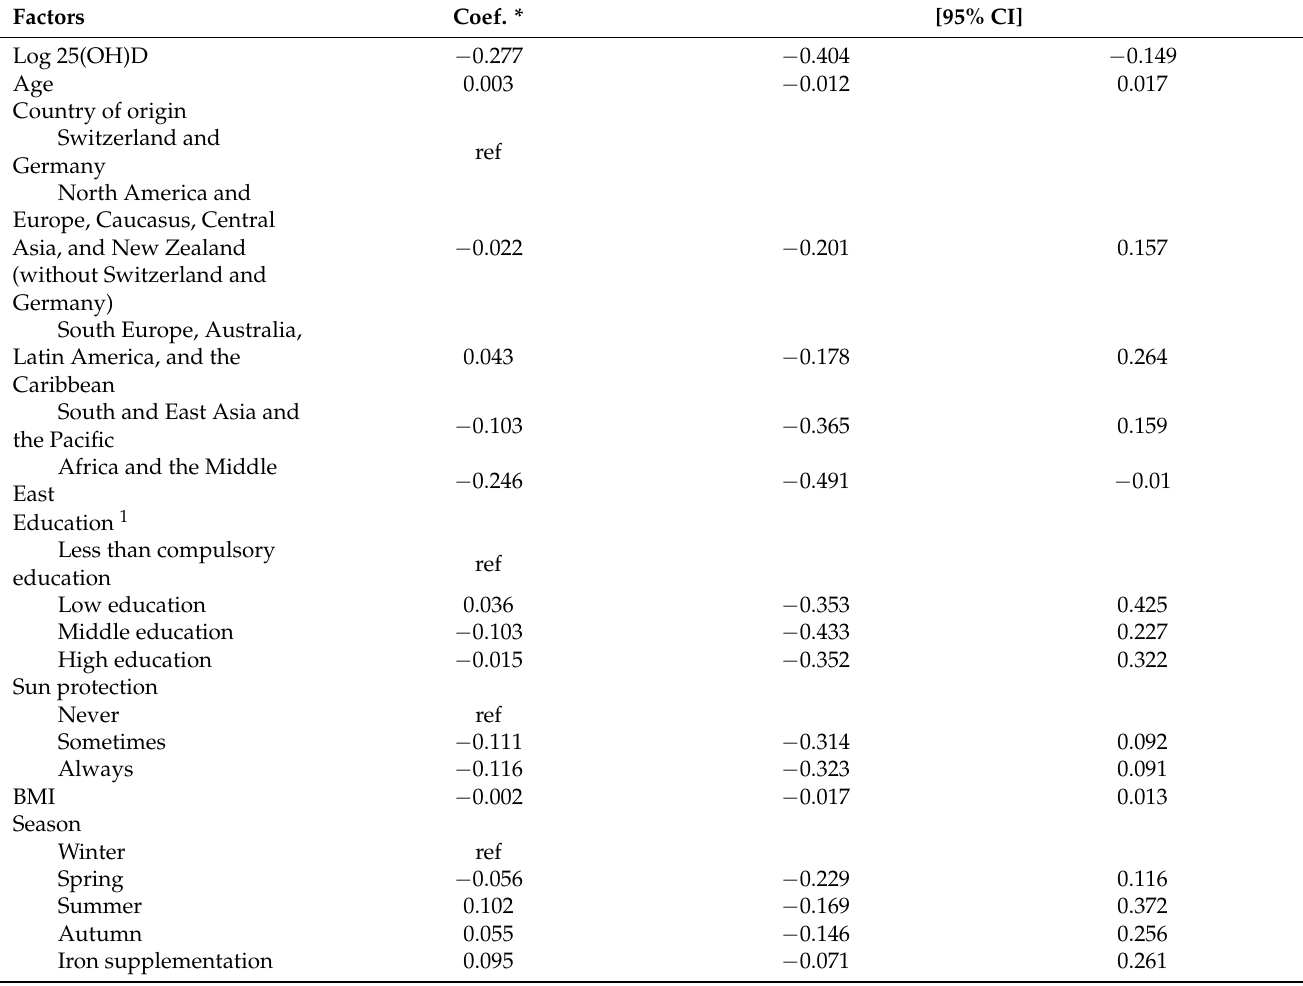
Table 3. Multiple regression analysis and determinants for log PTH concentrations in the 3rd